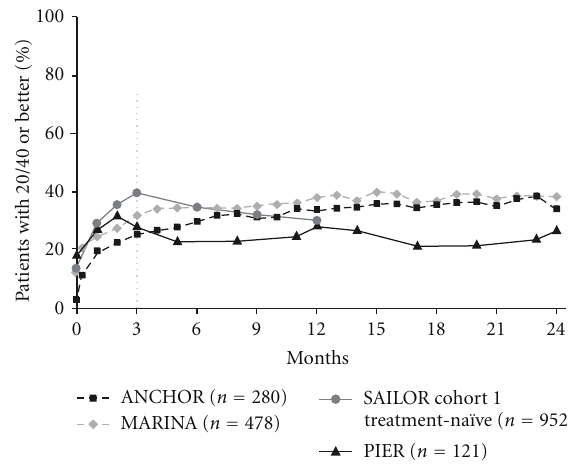
Figure 3: Time to first gain of ≥ 15 letters from baseline among pooled ranibizumab-treated patients by clinical trial. Dosing: ANCHOR and MARINA, monthly; PIER, months 0, 1, 2, 5, 8, 11, 14, 17, 20, and 23; SAILOR, months 0, 1, and 2, then as needed. Vertical line indicates switch from monthly to quarterly and as- needed dosing in PIER and SAILOR, respectively.